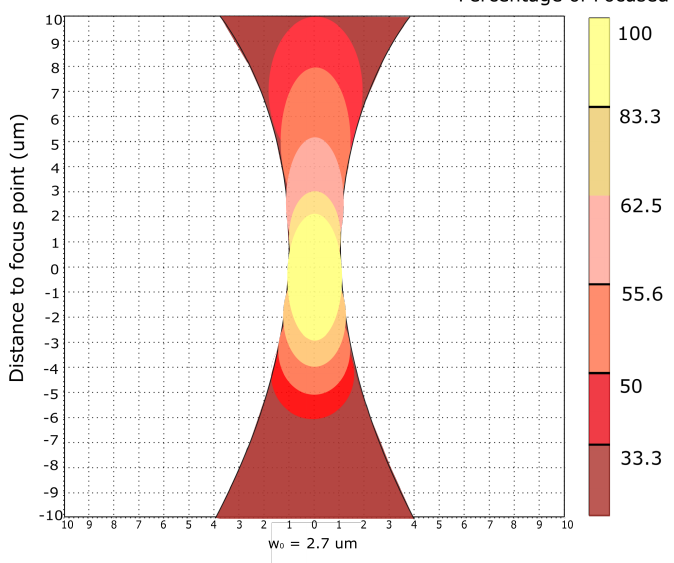
Figure 6. Energy distribution profile of focused laser